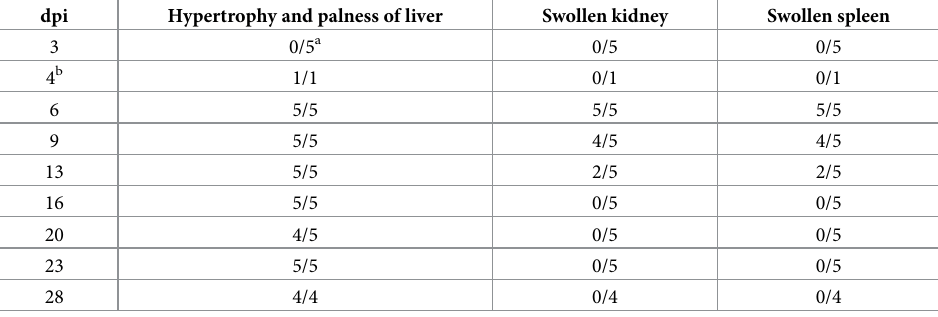
a No. birds positive/no. birds examined. b One chicken necropsied at 4 dpi was found dead.